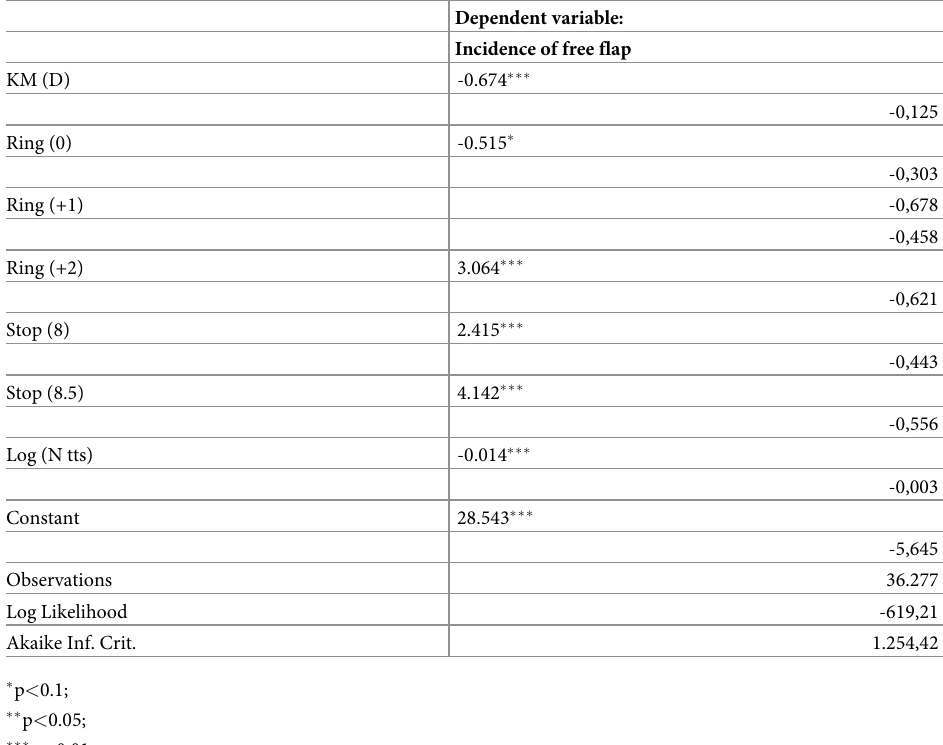
Table 4. Odds ratios of central corneal thickness and free flap